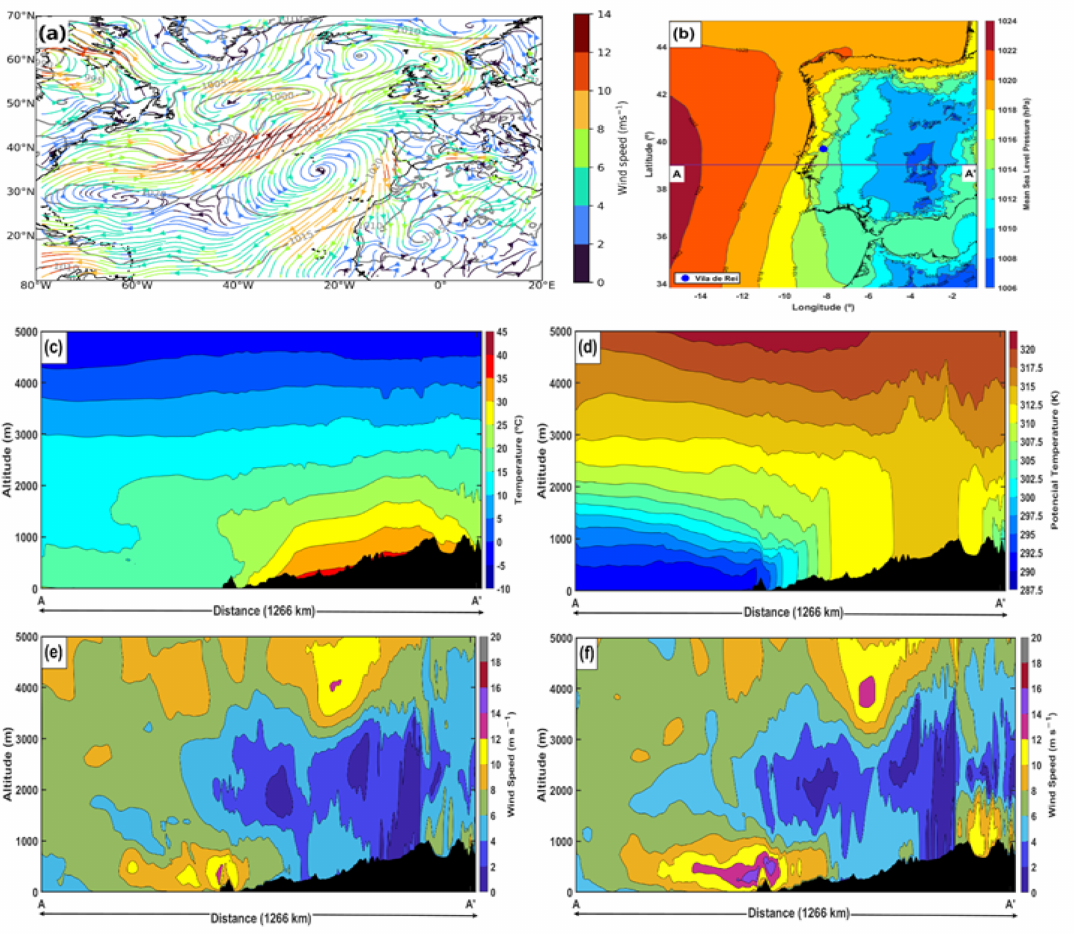
Figure 5. ( a ) Mean sea level pressure and surface wind speed at 1800 UTC on 20 July 2019, according to the ECMWF re-analyses; ( b ) Mean sea level pressure over the Iberian Peninsula from the Meso-NH simulation on 20 July 2019 at 1800 UTC; ( c ) Temperature at 1800 UTC; ( d ) Potential Temperature at 1800 UTC; and wind speed ( e ) at 1500 UTC and ( f ) at 1800